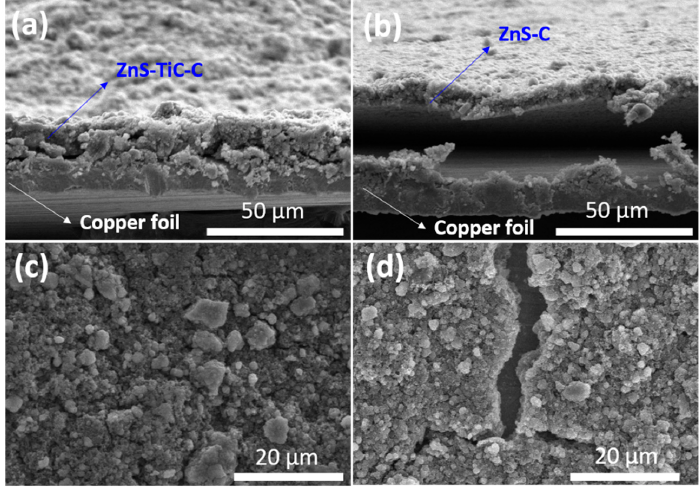
Figure 7. Ex situ SEM images of the (a, c) ZnS-TiC-C and (b, d) ZnS-C electrodes after 50 cycles at 0.1 A g − 1